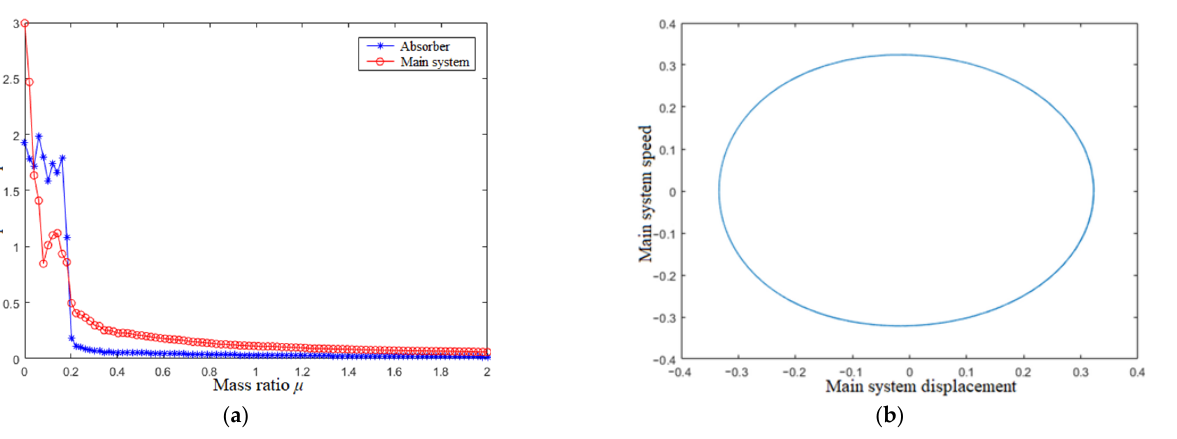
Figure 11. Response amplitude of two vibrators and phase diagram of main system in the case of resonance ω = 1.0. ( a ) Response amplitude; ( b ) Phase diagram ( μ = 0.4).